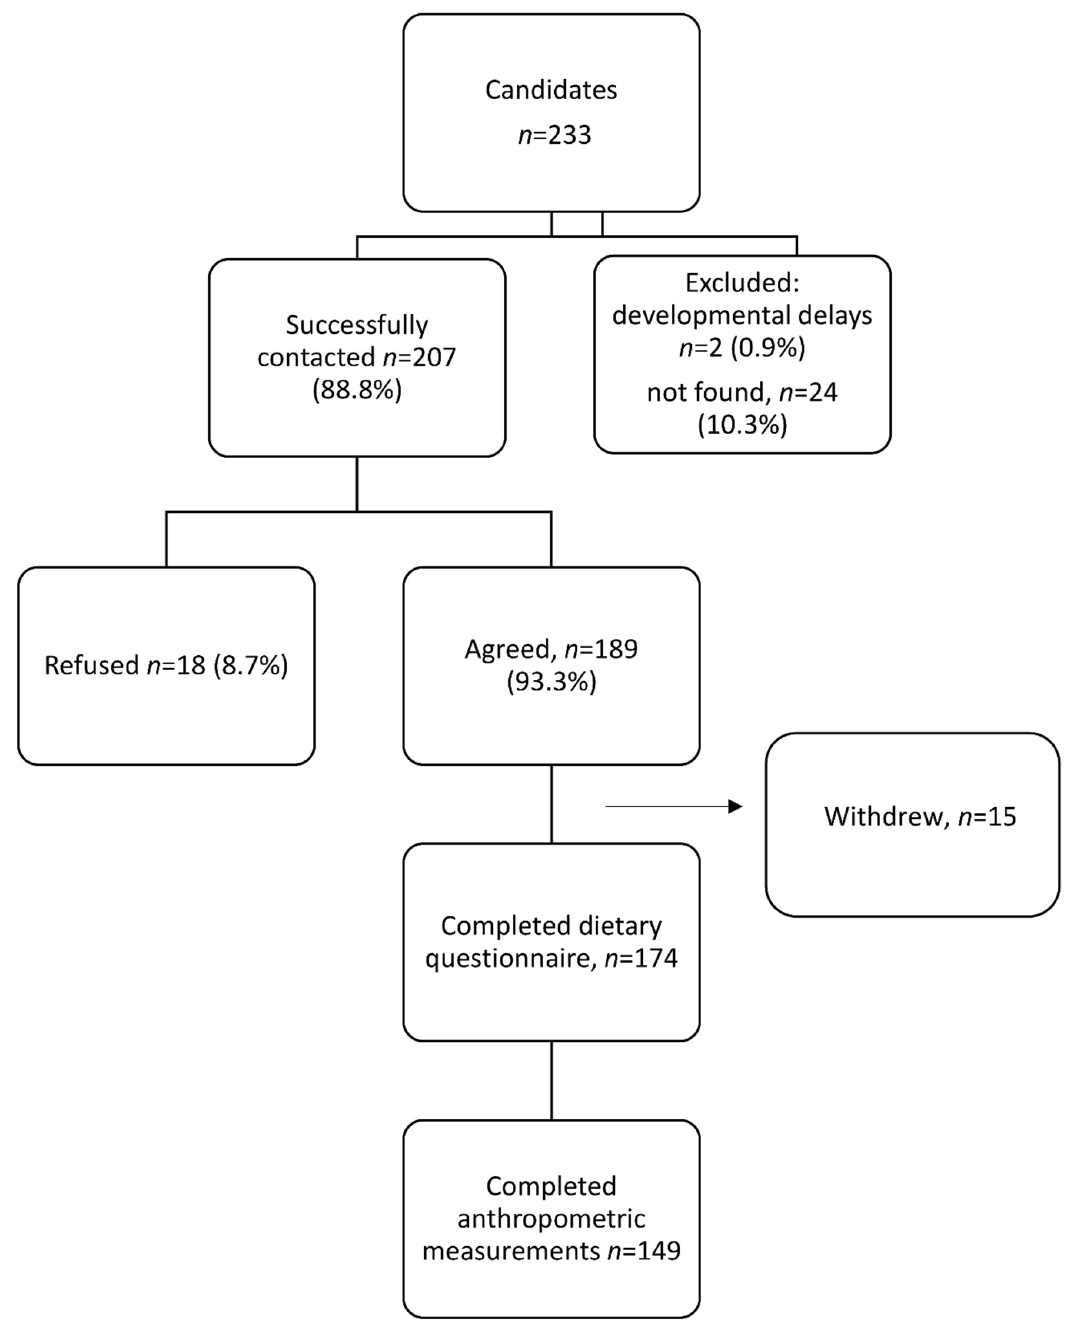
Figure 1. Flow chart of enrollment and data collection.